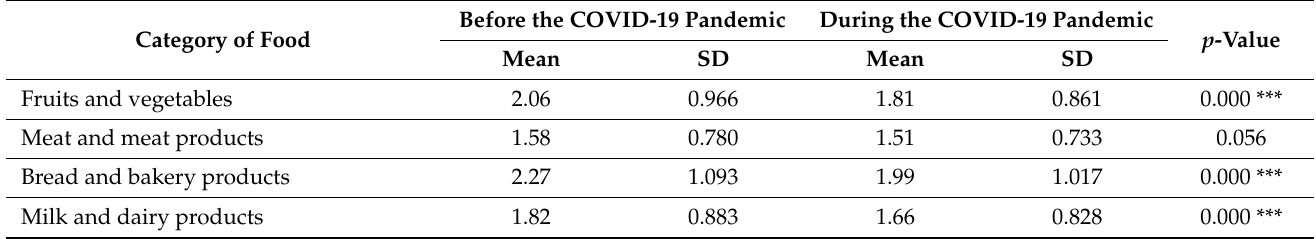
Table 5. Categories of food waste before the COVID-19 pandemic and during the COVID-19 pandemic. Category of Food